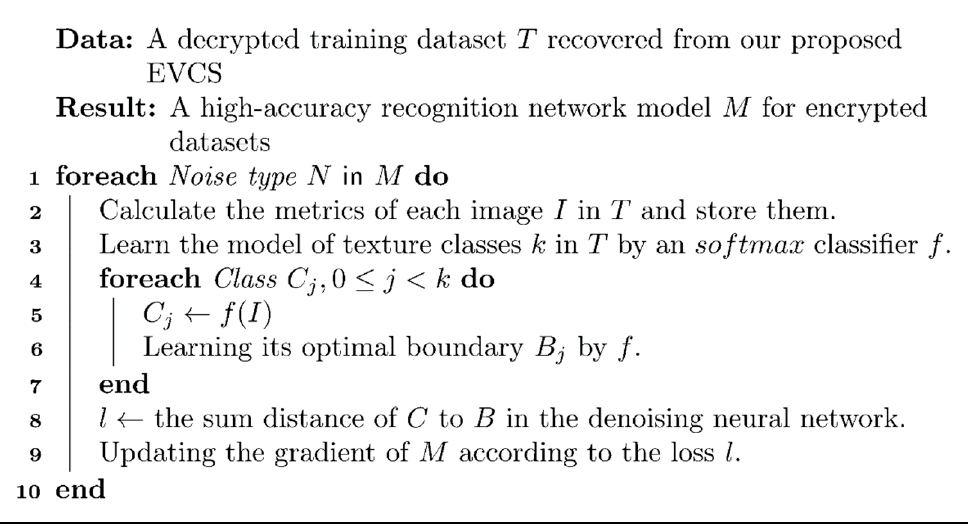
Algorithm 2 : A high-accuracy recognition neural network for encrypted datasets.